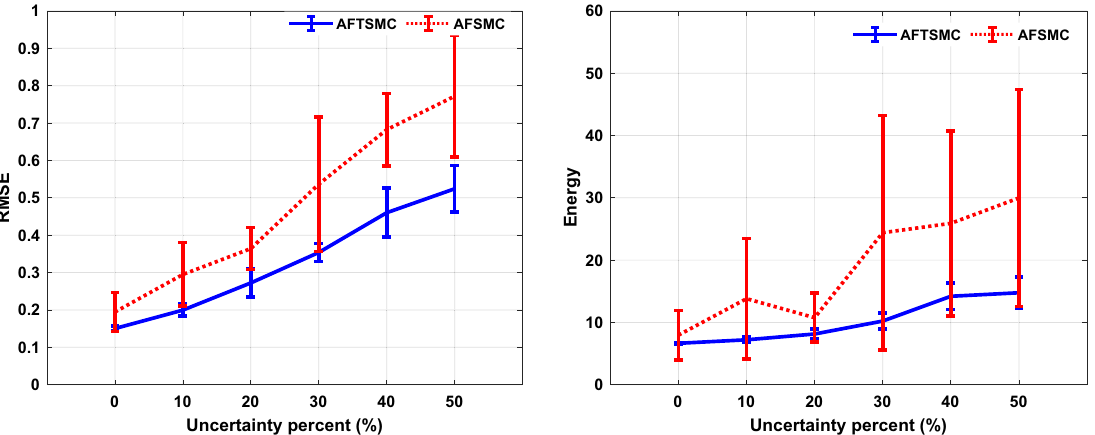
Figure 8. Results of the mean RMSE and Energy over 10 trials of the simulation under time-varying system parameters using AFTSMC in comparison with classical AFSMC. Standard deviation bars are shown for 10 independent simulations in each uncertainty.